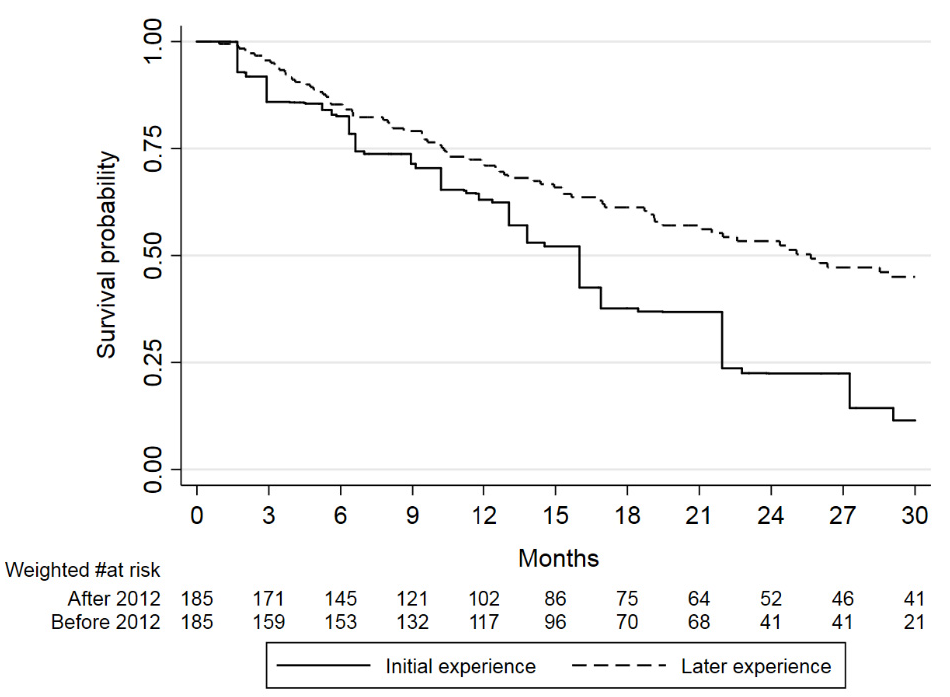
Figure 1. Overall survival in the reweighted population treated before 2012 and in the patients treated in the period from 2012–2020. These survival curves resulted from the balance of the baseline features and subsequent therapies reported in Table 2. The number of patients before 2012 is derived from the mathematical calculation of the weights generated using entropy balance. The HR was 0.53 (95% CI: 0.41–0.67) in favor of the most recent period ( p = 0.001).